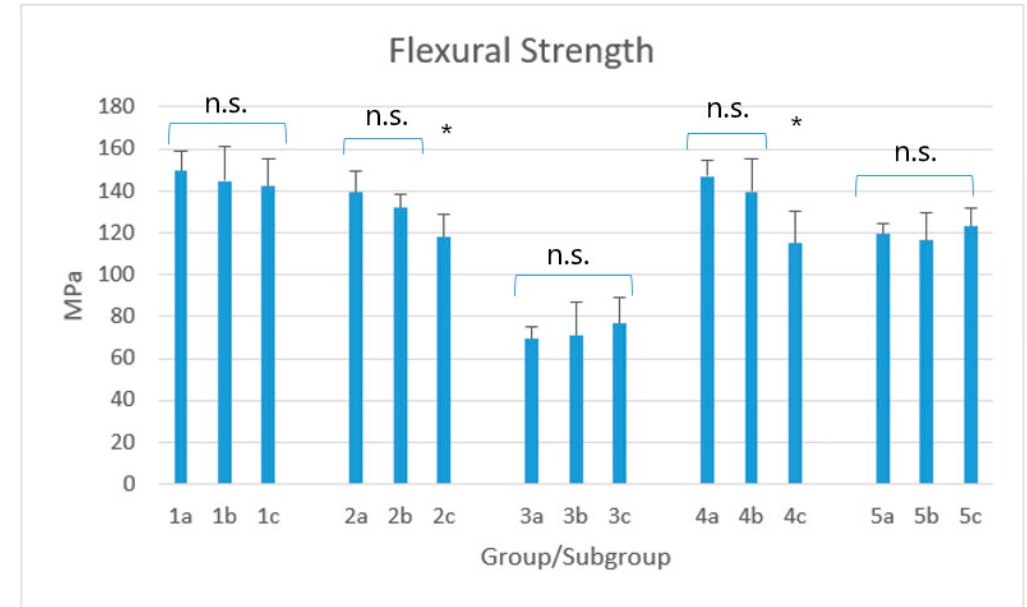
Figure 2. Mean flexural strength (MPa) for each group/subgroup. Legend: 1: x-tra fil; 2: GrandioSO x-tra; 3: Admira Fusion x-tra; 4: VisCalor bulk; 5: Enamel Plus HRi. Subgroups A (1a–5a): 4-week storage in 50 mL distilled water (control subgroups); Subgroups B (1b–5b): 3-week storage in 50 mL